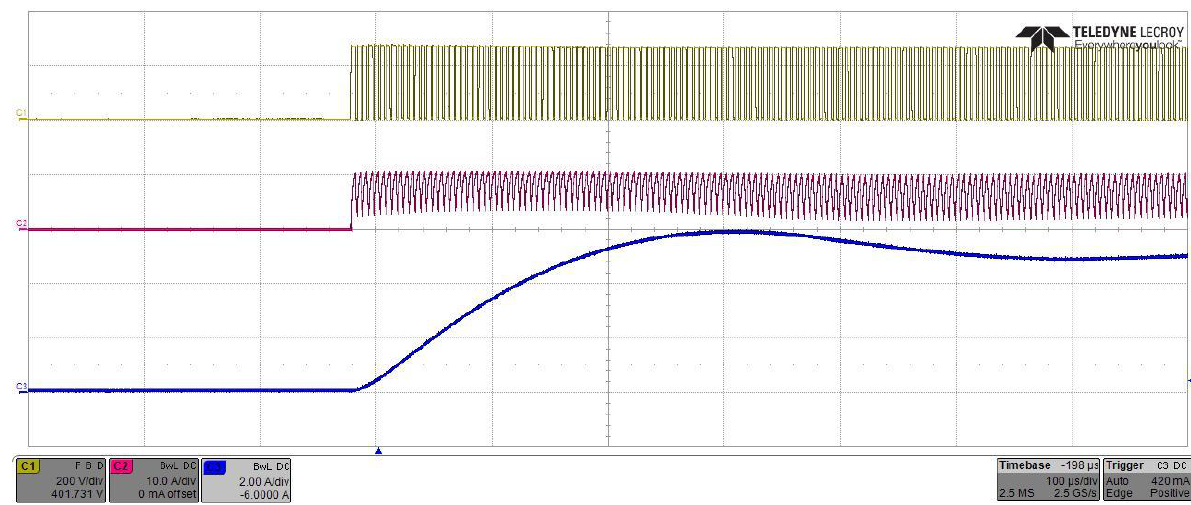
Figure 15. Response of the proposed SMC during controller start-up (load voltage (yellow), load current (purple), and input/EMA current (blue)).